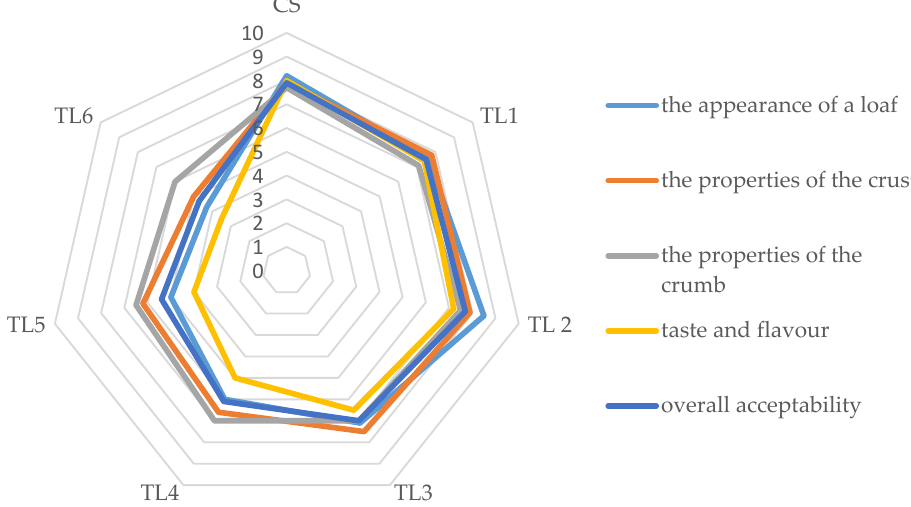
Figure 2. Results of sensory evaluation of bread enriched with Taraxacum officinale. CS—control sample of bread, TL1, TL2, TL3, Tl4, TL5, TL6—bread with 1, 2, 3, 4, 5, and 6 g 100 g − 1 of Taraxacum officinale , respectively.